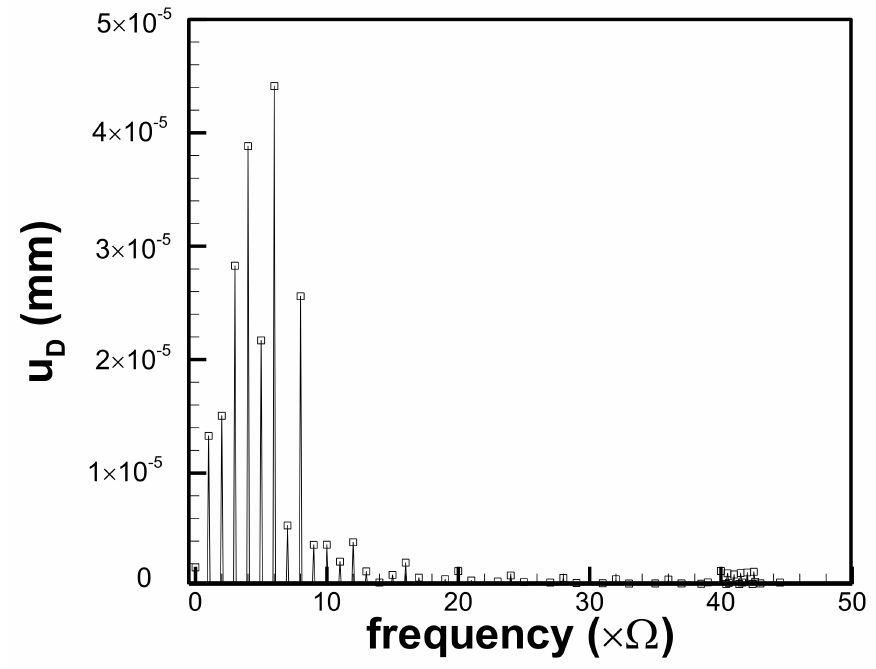
Figure 9. The FFT spectrum of the follower output node D in the axial direction where Ω = 320 rad/s. Table 2. The peak amplitude of the lateral vibration spectrum of the follower output node D for the three RDFD motions where Ω = 320 rad/s.